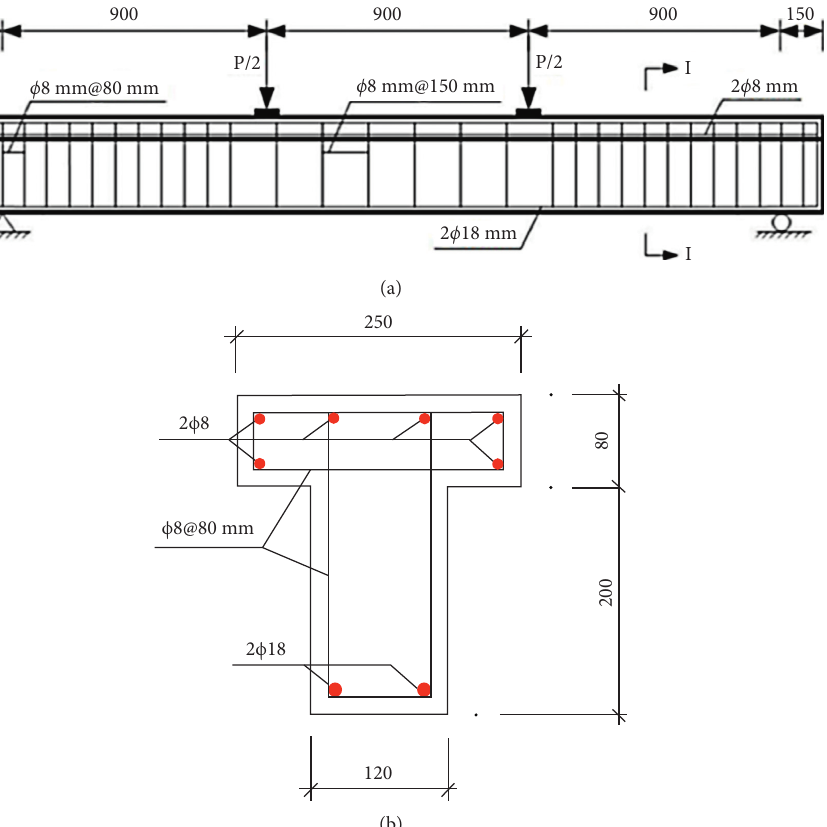
Figure 2: Section parameters of the beam to be reinforced. (a) Longitudinal section. (b) Section 1-1. Table 10: Reinforcement of each beam. Beam